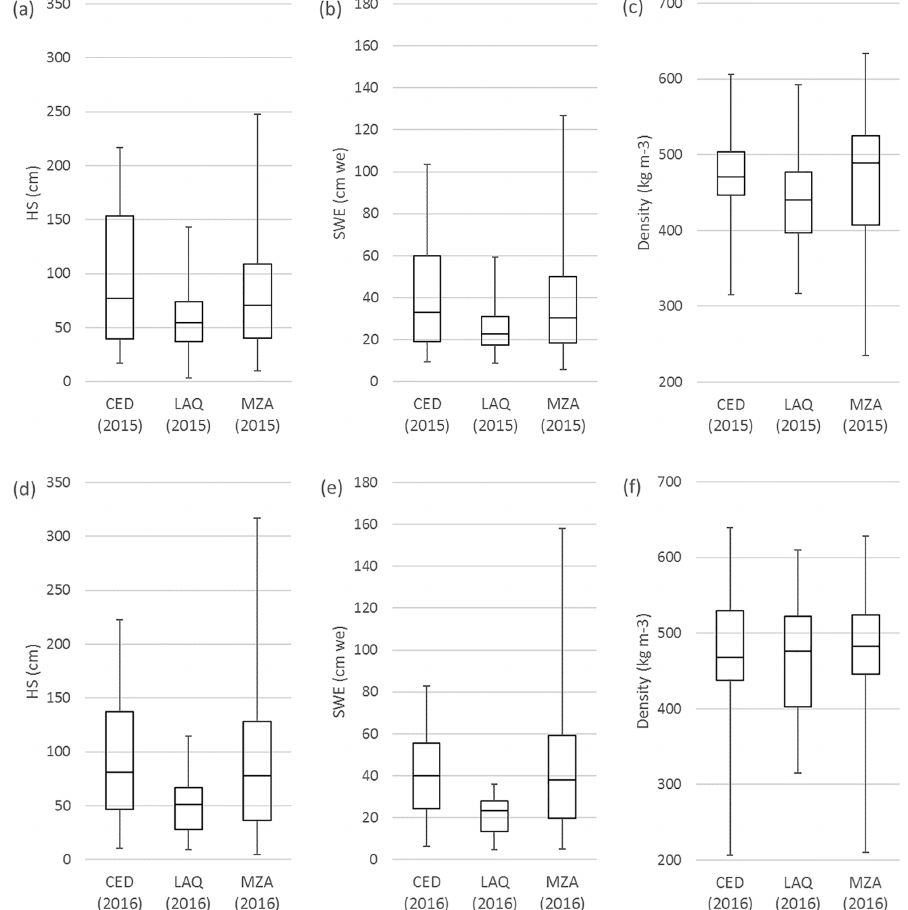
Figure 7. Box-and-whisker plots for nonzero data: (a) snow height (HS), (b) SWE, and (c) snow density over snow season 2014–2015 ( n = 311) and (d) snow height (HS), (e) SWE, and (f) snow density over snow season 2015–2016 ( n = 371) distributed by region: CED (elevation range, 1650–2900m), LAQ (1300–1850m), and MZA (1350–2350m). The box brackets represent 25 and 75% of the data (lower and upper boxes, respectively). The whiskers are at minimum and maximum